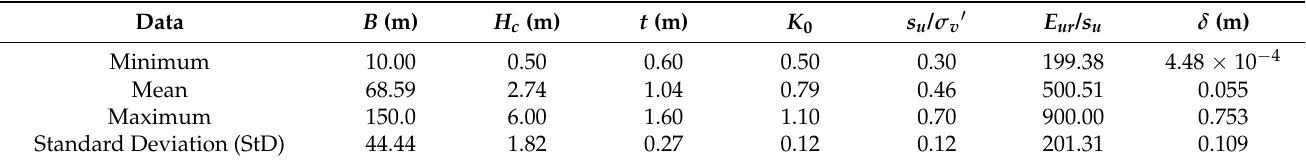
these data sets is presented in Table 1. In this database, the excavation width B is distrib- uted between 10.00 and 150.00 m, the excavation depth H c is distributed between 0.50 and 6.00 m, the wall thickness t is distributed between 0.60 and 1.60 m, the at-rest lateral earth pressure coefficient K 0 is distributed between 0.50 and 1.10, the soil shear strength ratio at mid-depth of the wall s u / σ v ′ is distributed between 0.30 and 0.70, and the soil stiffness ratio at mid-depth of the wall E ur /s u is distributed between 199.38 and 900.00. Table 1. Statistical results of these datasets. Table 1. Statistical results of these